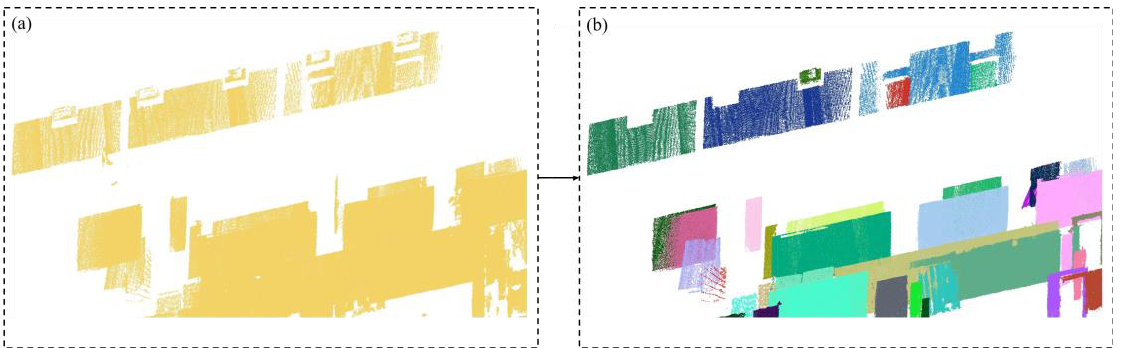
Figure 5. Instance segmentation of planes. ( a ) Planes in the same cluster and ( b ) the corresponding instantiation.